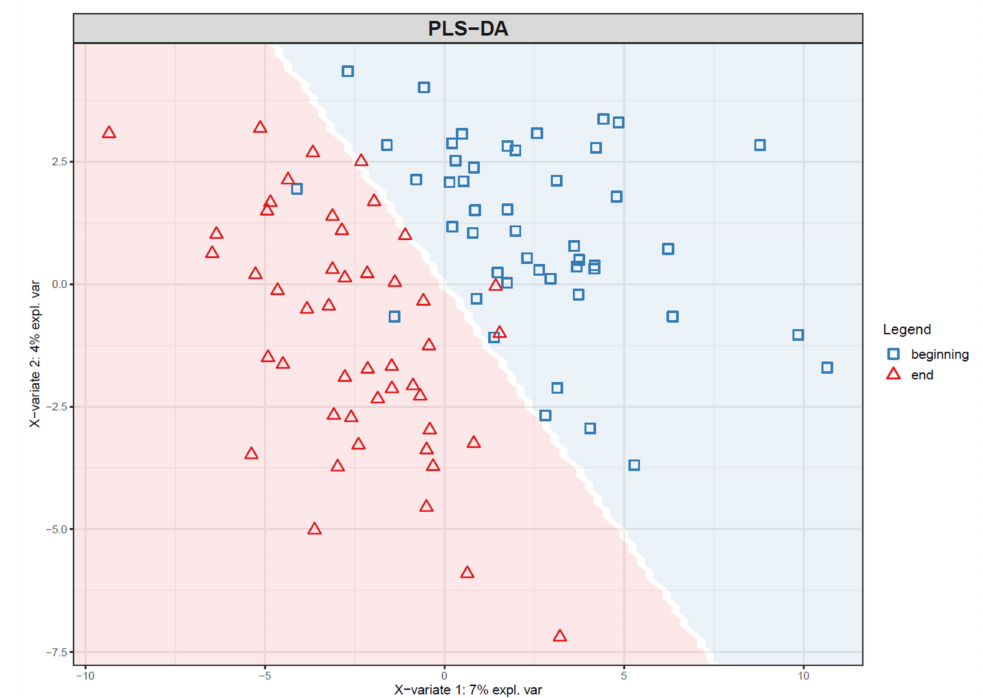
Figure19. Scoreplotofthefirsttwocomponentsofapartialleastsquares-discriminantanalysis(PLS-DA) model trained to predict the time point of samples from an intervention study. The background color indicates the prediction of the model: samples in the blue area are classified to time point “beginning” and samples in the red area to time point “end”. Note that the time points are clearly more separated than in the corresponding principal component analysis (PCA) plot (Figure 18). This is to be expected, as PLS-DA finds components that specifically separate the two time points.